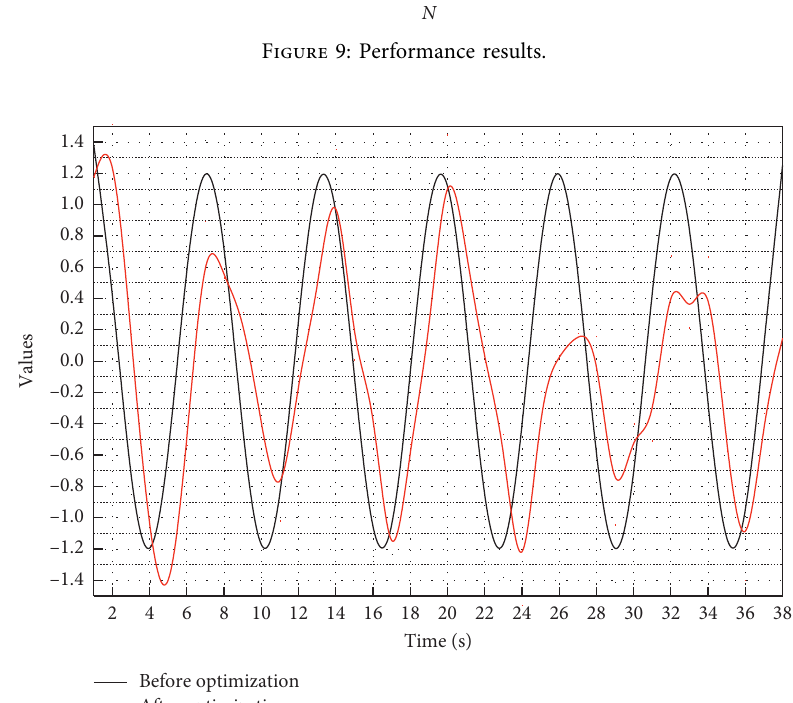
Figure 10: Performance test results analysis.